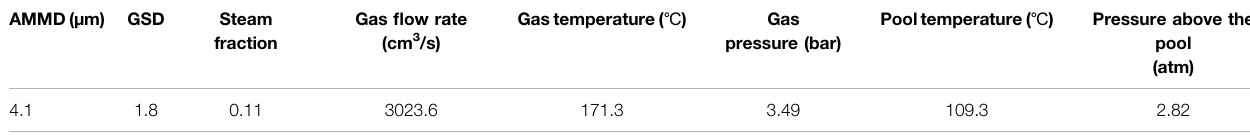
TABLE 8 | Main parameters about RT-MB-01/02 condition of LACE-Espana experiment. AMMD( μ m)